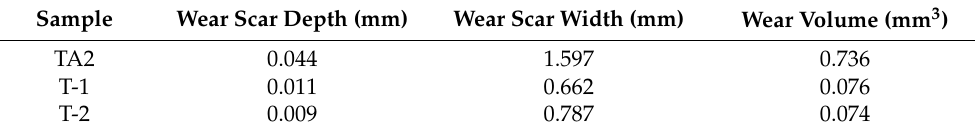
Figure 12. Cross ‐ section wear scratch diagram of TA2, T ‐ 1 and T ‐ 2. Table 2. Measured wear scar width and depth and calculated wear volume.